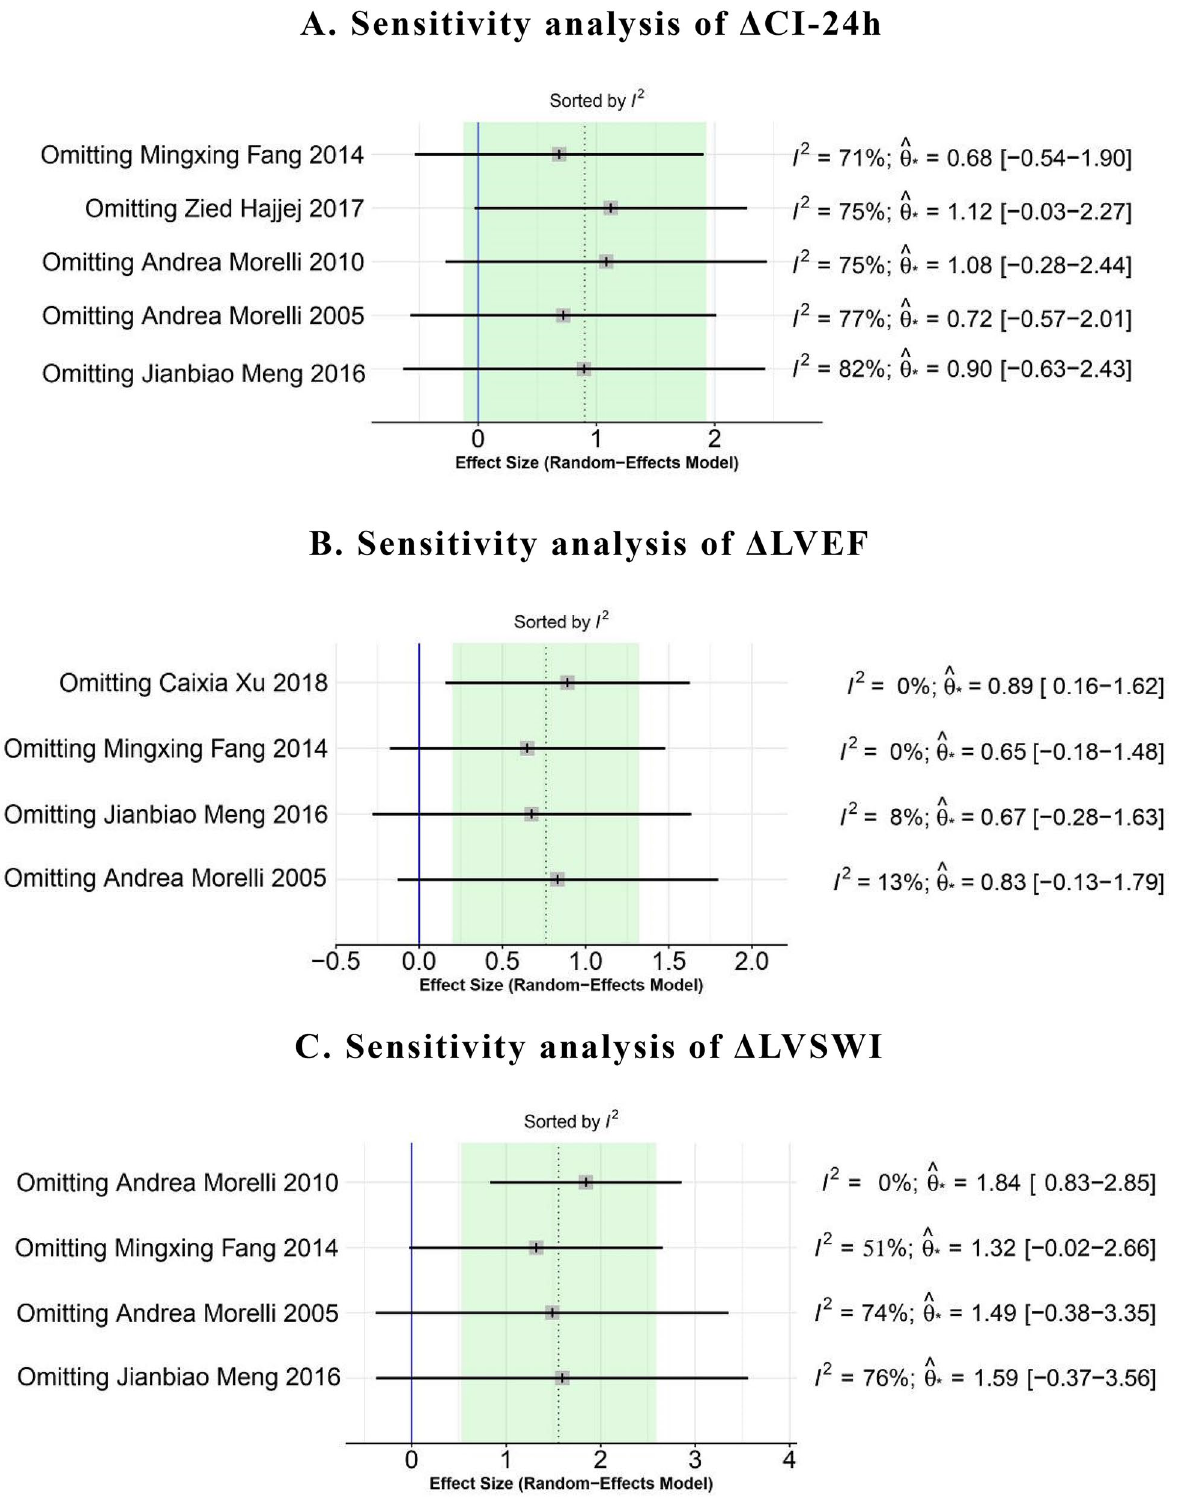
Figure 6. Sensitivity analysis of the changes of cardiac function parameters. ( A ) Sensitivity analysis of ΔCI- 24 h. ( B ) Sensitivity analysis of ΔLVEF. ( C ) Sensitivity analysis of